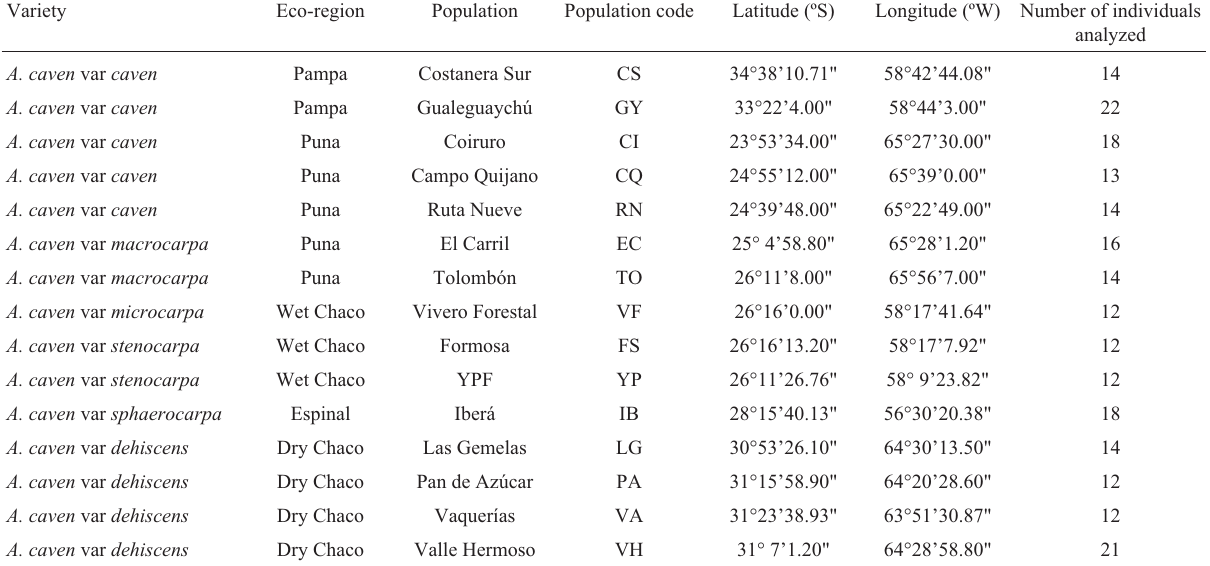
Table 1 - Populations of Acacia caven sampled in this study.